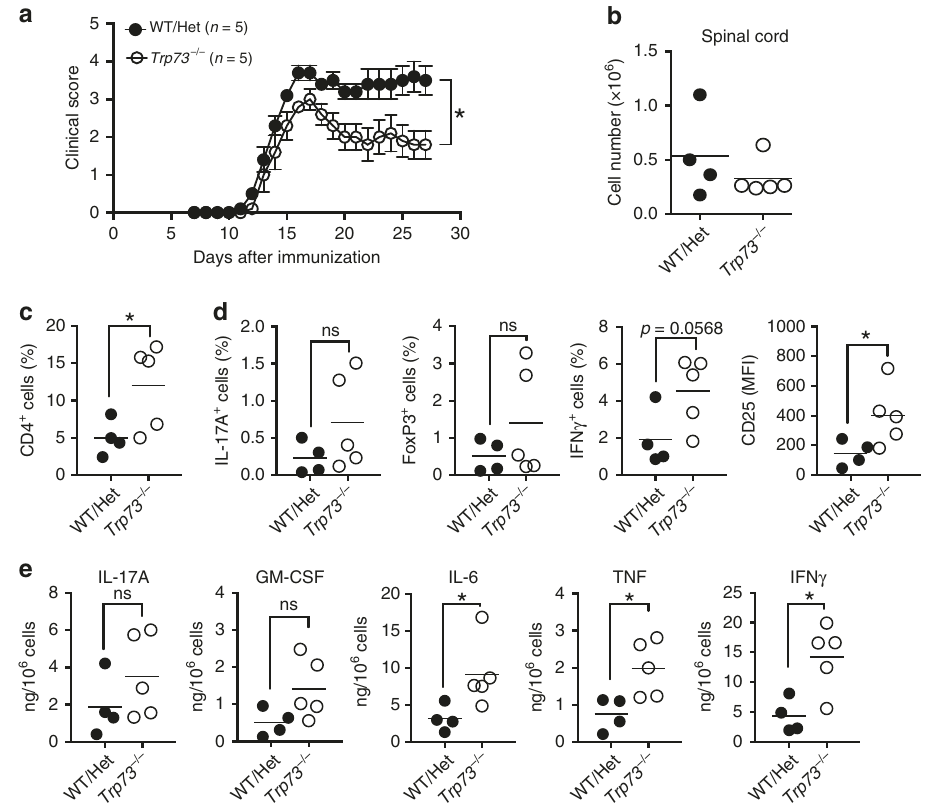
Fig. 6 Trp73 gene deletion reduces disease severity in EAE mice. a Clinical scores for groups of Trp73 − / − mice and wild-type/heterozygous (WT/Het) littermates after immunization with MOG 35 – 55 are shown as mean values ± S.E.M. Data were analyzed by a two-tailed unpaired t test; P values are indicated (* P < 0.05). b – e Total lymphocytes were isolated from the spinal cords from WT/Het ( n = 4) or Trp73 − / − ( n = 5) mice 27 days after EAE induction. b Total recovered cell numbers. c In fi ltrating lymphocytes from the spinal cord were analyzed by fl ow cytometry and the percentage of CD4 + T cells is shown. d , e Total cells from the spinal cord were stimulated with MOG 35 – 55 for 48 h, and then the percentage of IL-17A + CD4 + , FoxP3 + CD4 + , and IFN γ + CD4 + cells and CD25 expression (MFI) were determined by fl ow cytometry and shown as indicated. e IL-17A, GM-CSF, IL-6, TNF, and IFN γ levels in culture supernatant after MOG 35 – 55 stimulation were determined using a LEGENDplex Multi-Analyte assay. The results were normalized against total cell numbers. All data are presented as scatter dot plots with mean values indicated and analyzed by a two-tailed unpaired t test using mean ± SEM values; P values are indicated (ns P ≥ 0.05; * P < 0.05). Data are from one representative of three experiments with n = 5 mice per group in each experiment. Source data for a – e are provided in a Source Data